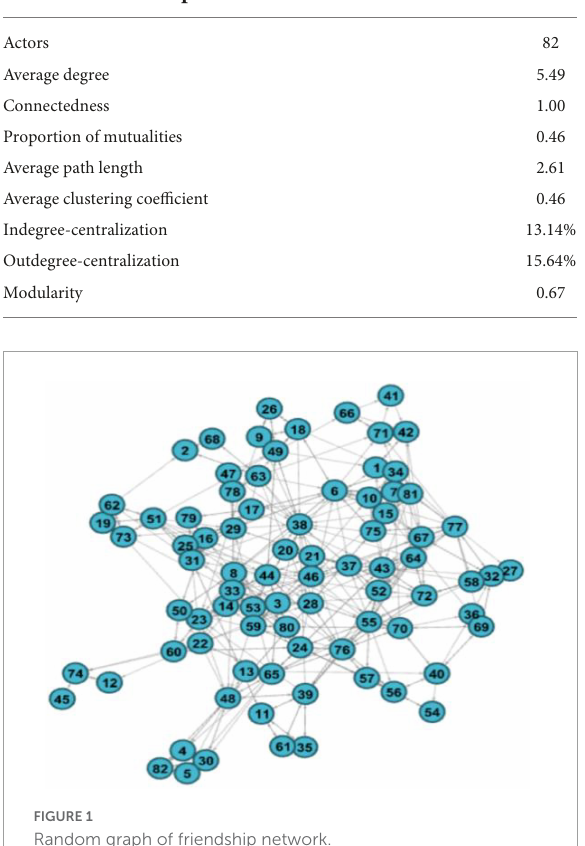
FIGURE1 Random graph of friendship